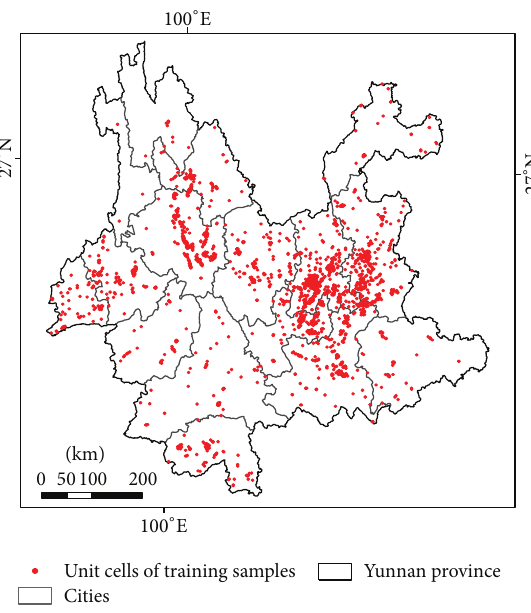
Figure 3: Distribution of training